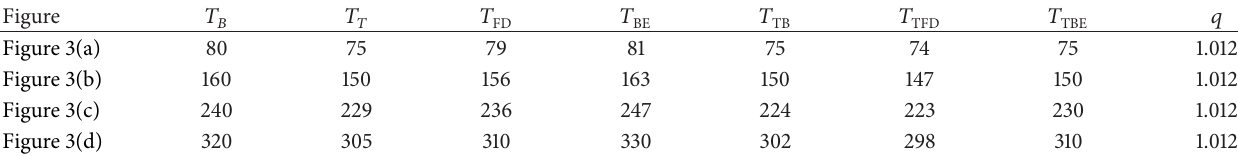
Table 1: Values of parameters corresponding to different distributions in Figure 3. The temperatures are in the units of